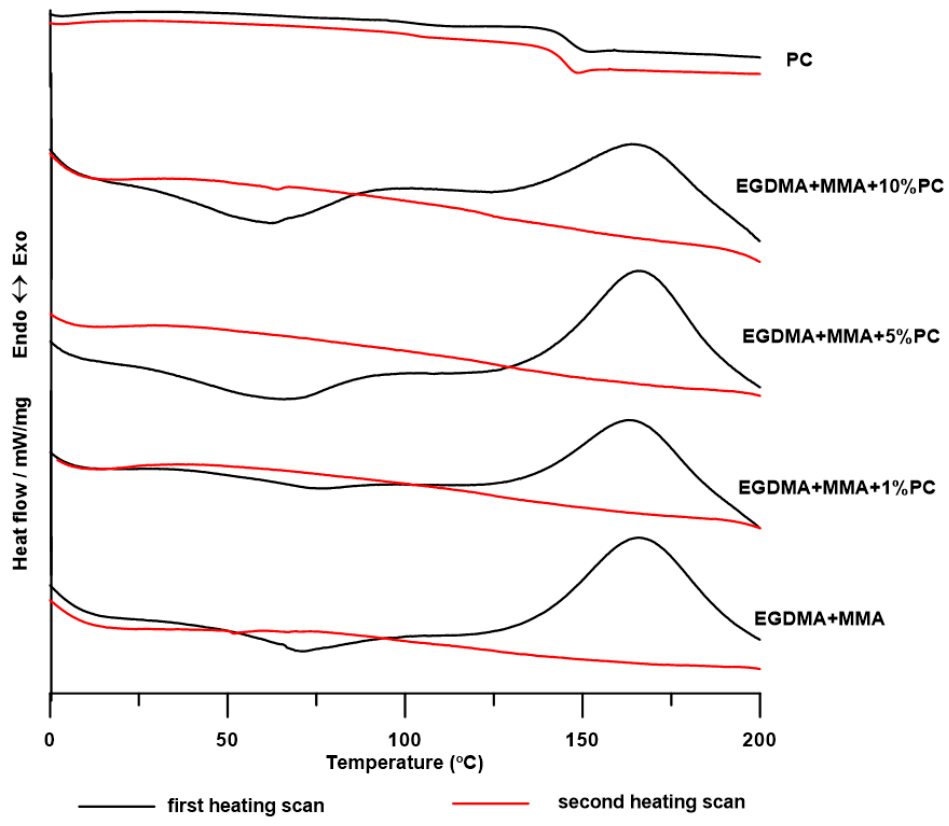
Figure 9. DSC curves for EGDMA + MMA blends.